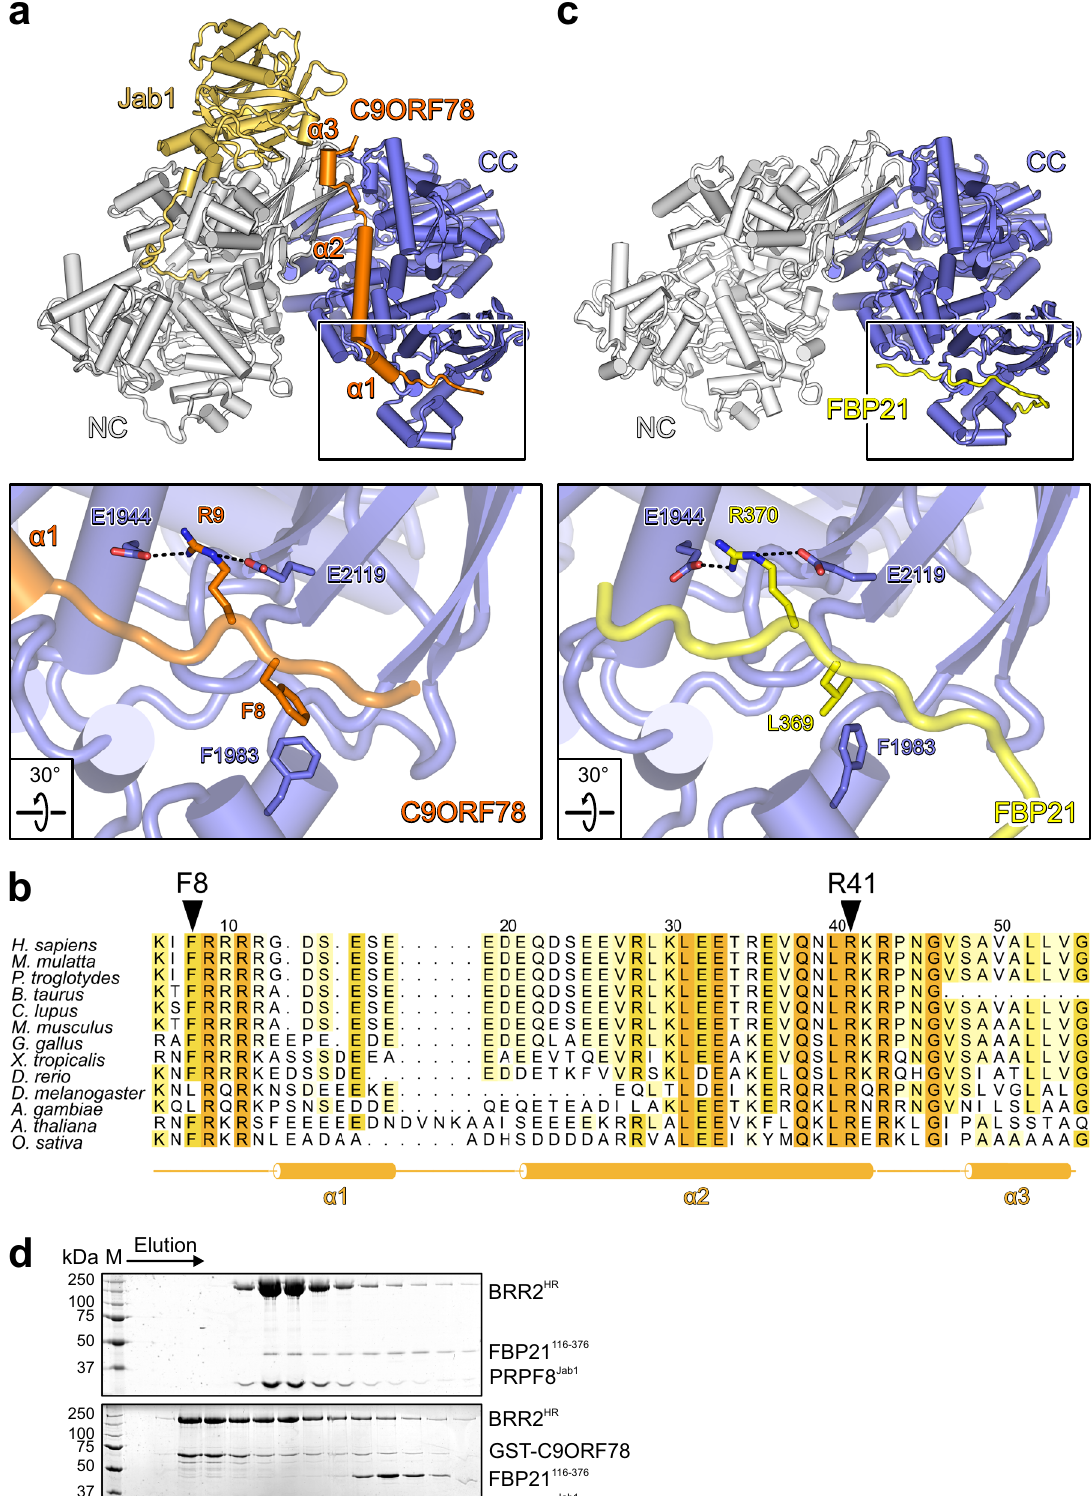
− 17.9 kcal/mol). Therefore, despite similar size interfaces, we expect the BRR2 HR -C9ORF78 interaction to be signi fi cantly weaker and more transient than the BRR2 HR -PRPF8 Jab1 interac- tion, for which a K d of about 8 nM has been estimated in yeast 46 . Taken together, the mode of BRR2 binding observed for C9ORF78 re fl ects its intrinsically unstructured nature 47 ; it